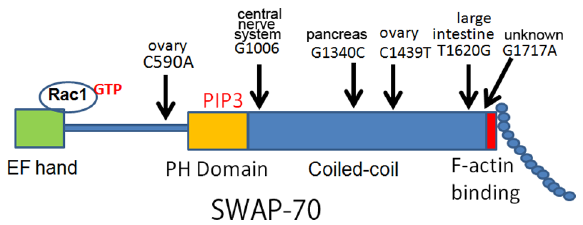
Figure 1. SWAP-70 gene and the mutations found in human tumors. The SWAP-70 coding region is shown in the middle. It has an EF-hand-like domain, which contributes to binding of activated Rac1. In the center portion, the protein has a PH domain that is responsible for